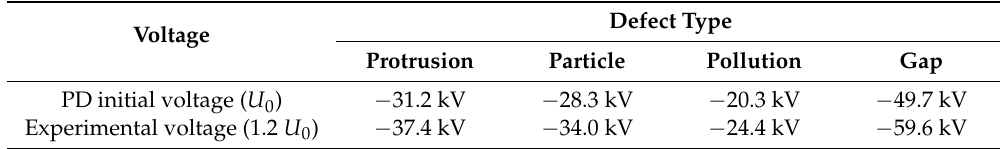
Table 1. Experimental voltages under four kinds of defects.